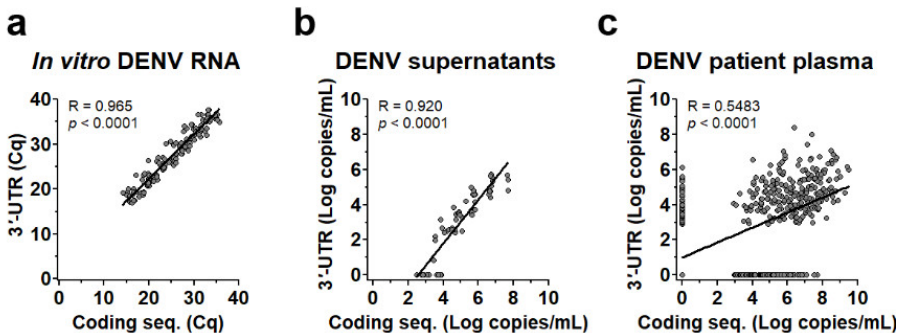
Figure 2. Correlation of DENV genome levels quantified by RT-PCR specific to 3′-UTR and coding sequence. Quantification cycle (Cq) values or DENV genome levels (Log copies/mL) in various types of samples quantified by RT-PCR using the two types of probe/primer regions were compared and analyzed for correlation coefficient (R) and p values of linear regression. ( a ) A correlation plot showing Cq values from quantification of 144 samples of in vitro transcribed DENV1-4 RNA (ranging from 10 1 –10 6 copies/mL) from 6 independent experiments. ( b ) A correlation plot showing DENV genome levels (Log copies/mL) in DENV1-4 infected cell cultured supernatants (2–200,000 ffu/mL) from 15 independent experiments. ( c ) A correlation plot showing DENV genome levels (Log copies/mL) measured in plasma of 161 DENV infected patients collected since the first day of hospitalization to the day to defervescence (499 samples in total).